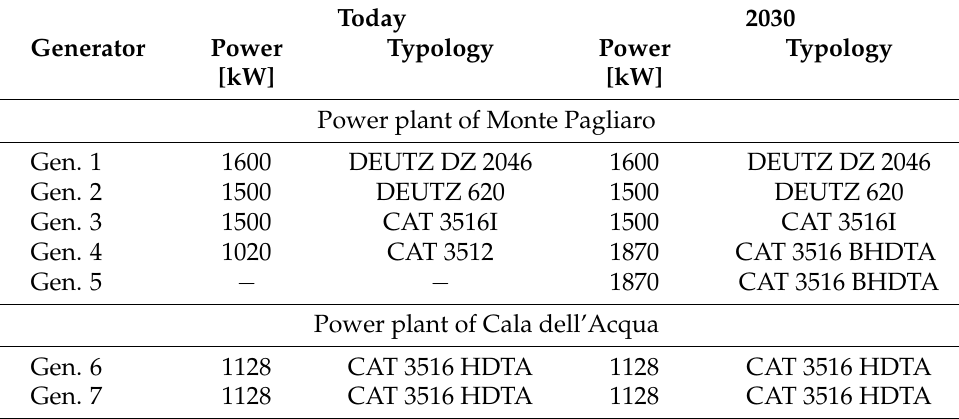
Table 13. Evolution of diesel generators to 2030.